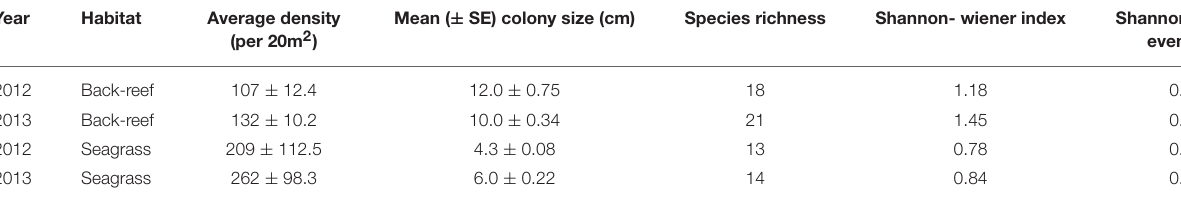
TABLE 3 | Summary of established coral community characteristics in the back-reef and seagrass habitats of Little Cayman, Cayman Islands.